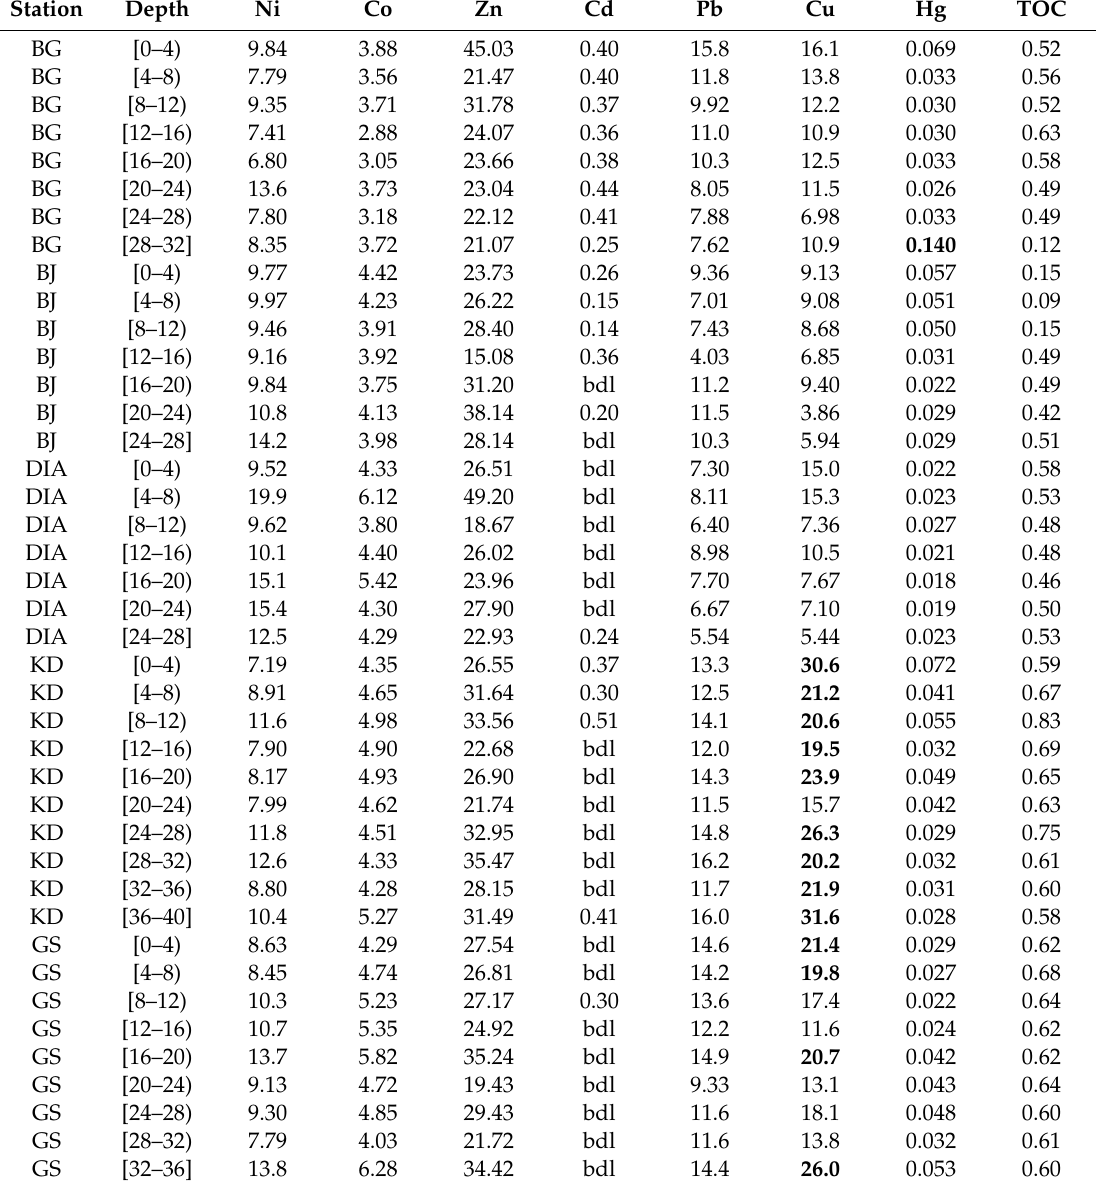
Table 3. Metal(loid) concentrations (mg / kg) and total organic carbon (%) in sediments in depth (cm) in the sampling’s stations (BG: Babughat; BJ: Baj-Baj; DIA: Diamond Harbour; KD: Kakdwip; GS: Ganga-Sagar) along the Ganges River and the Hügli